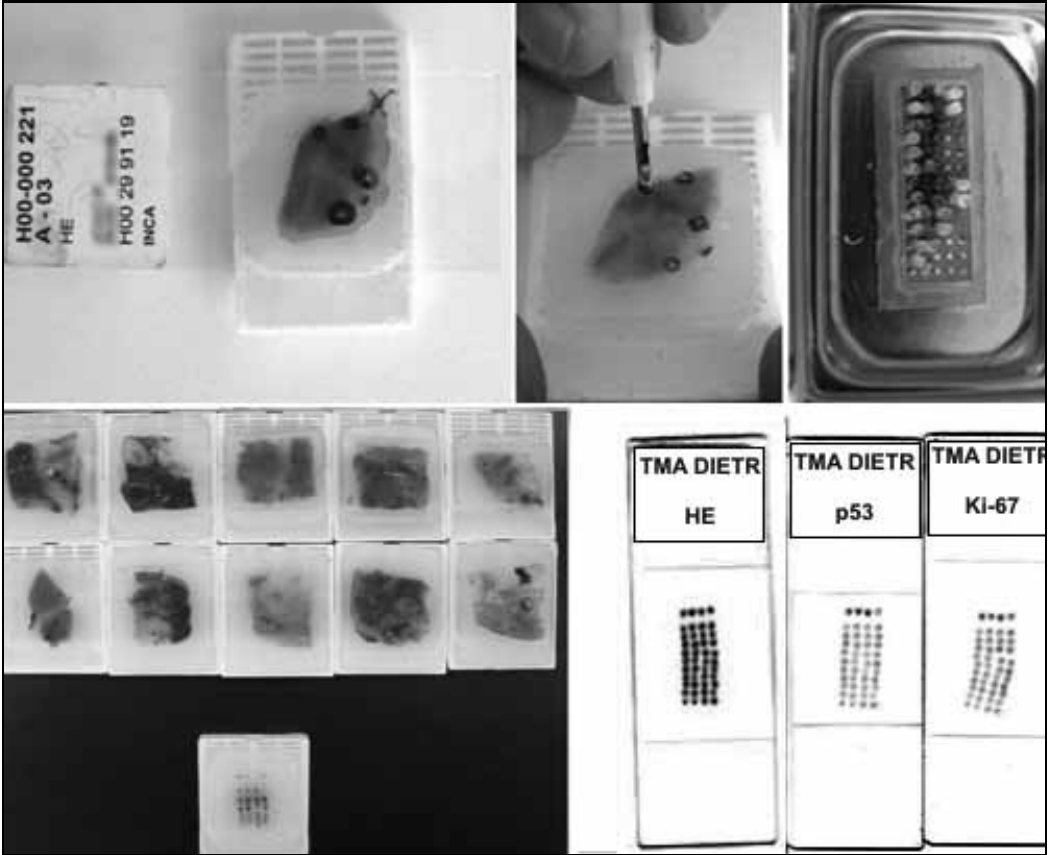
Figura 2 – Procedimento de construção dos blocos de TMA Lâmina histopatológica corada por HE com áreas de interesse marcadas (x = DIETR e o = CCR), sobreposta ao respectivo bloco doador e posterior punção de área marcada; molde parcialmente preenchido pelos cilindros puncionados; blocos doadores e bloco de TMA resultante e lâminas de TMA – HE e IHQ com anticorpos antiproteína p53 e antígeno